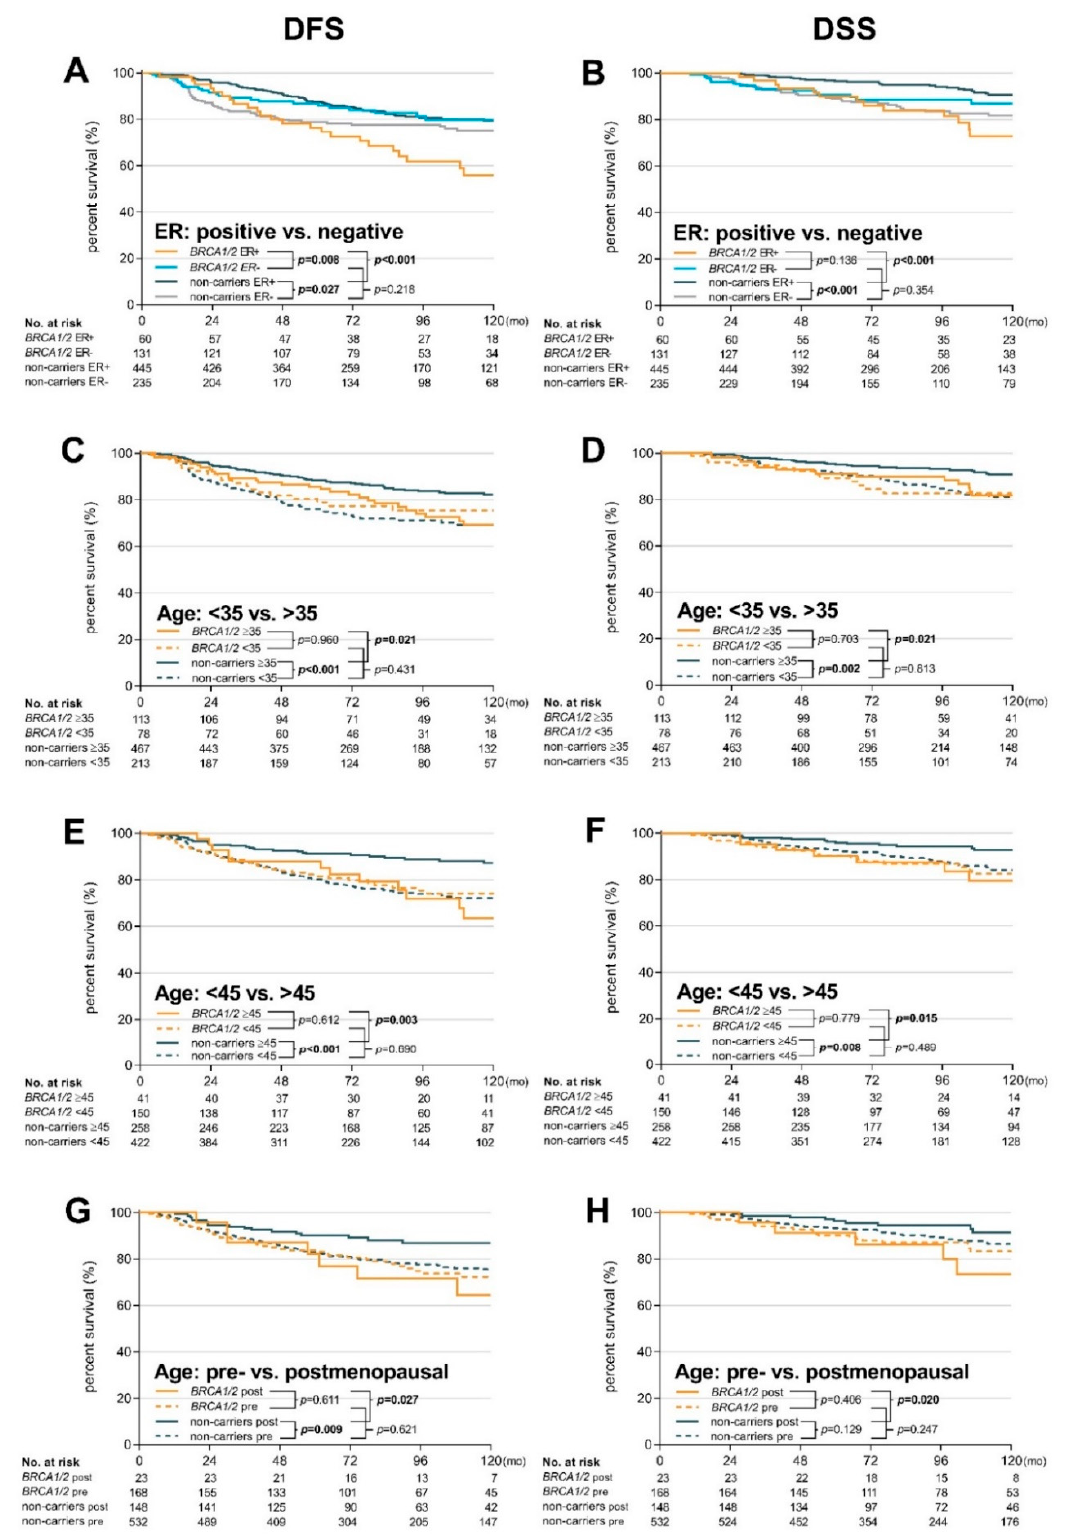
Figure 2. Kaplan–Meier plots of DFS and DSS for: ( A , B ) ER status (positive vs. negative); ( C , D ) age ( < 35 vs. ≥ 35); ( E , F ) age ( < 45 vs. ≥ 45); and ( G , H ) menopausal status (pre- vs. post-menopausal).